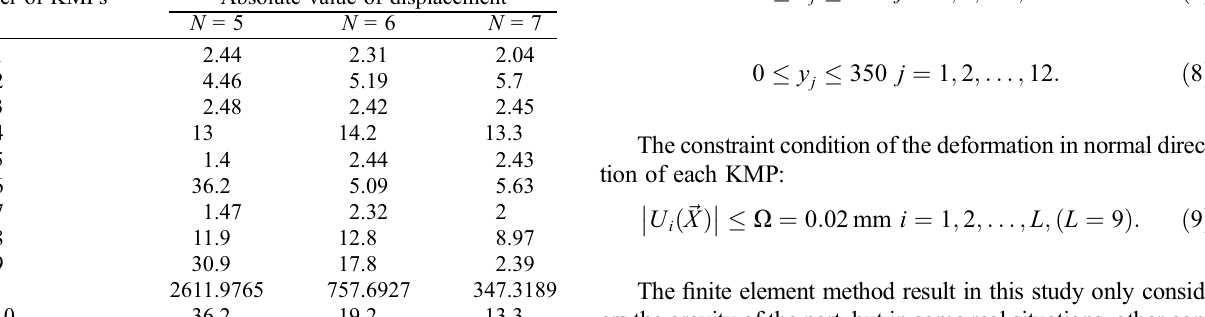
Table 2. Objective function values when N = 5, 6, 7 ( · 10 (cid:4) 3 mm). Number of